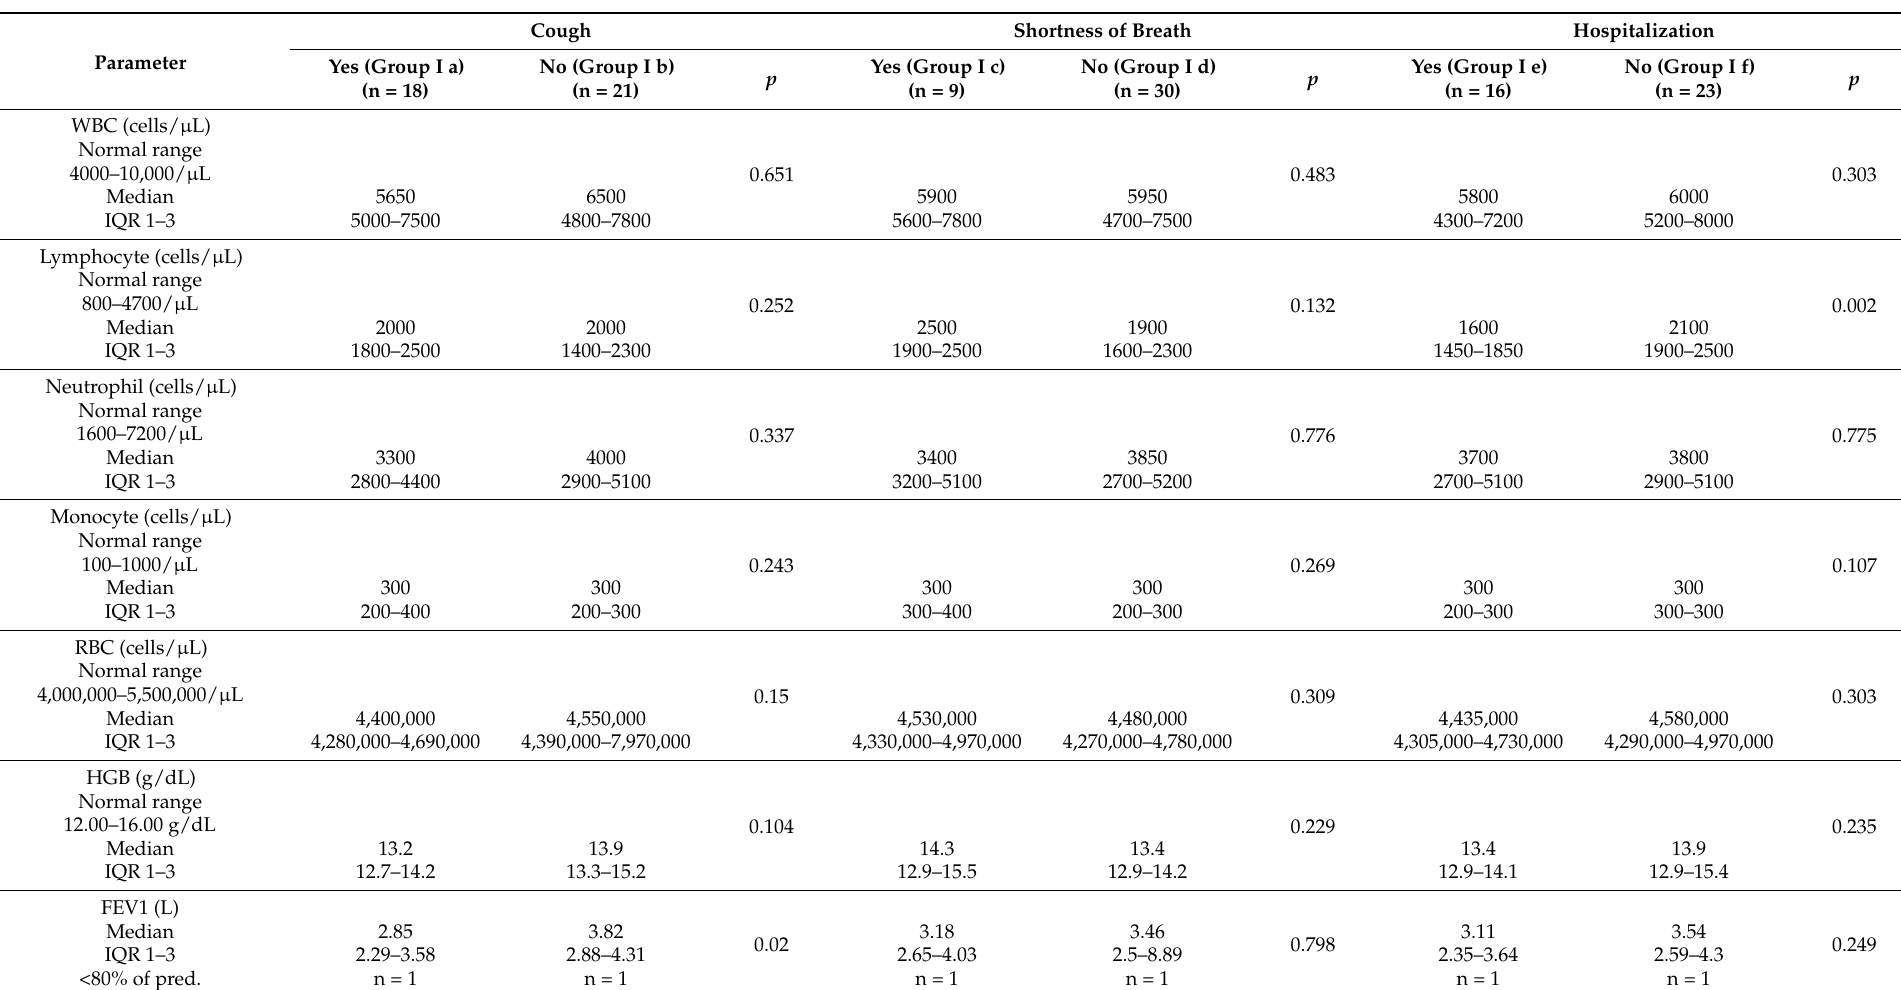
Table 2. The median, range, and statistical significance of laboratory tests and pulmonary function tests in patients 6 months after COVID-19 (post-COVID-19) who reported a persistent cough and shortness of breath, depending on hospitalization during the acute phase of